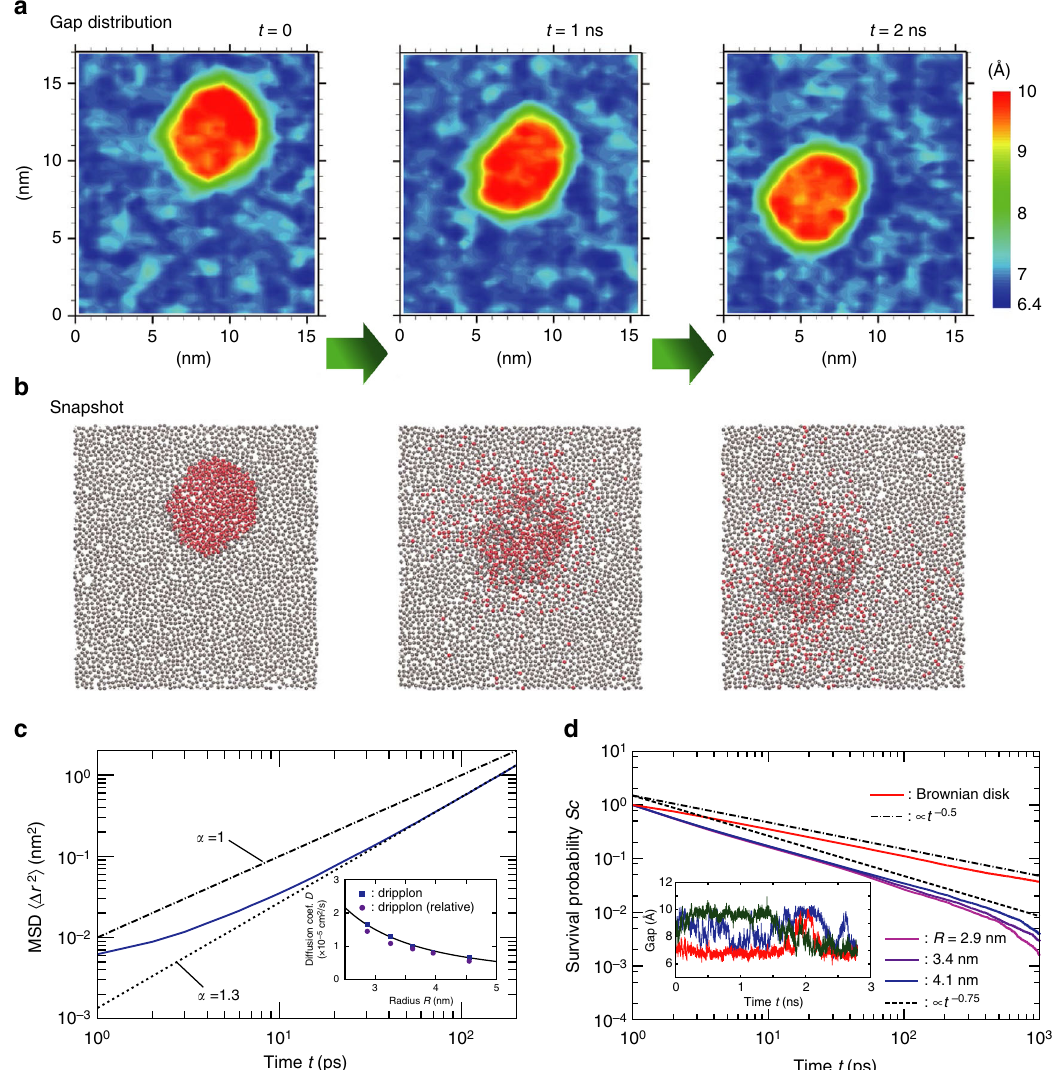
Fig. 5 Dripplon dynamics. a Displacement of a dripplon over time, compared with diffusion of water molecules initially in the dripplon, which is visualized in b . The water molecules belonging to the dripplon at t = 0 are colored in red in b . The average density is ρ av = 12.3 nm − 2 , in the graphene sheets of S = 15.7 × 17.0 nm 2 . See Supplementary Movie 4 for the corresponding video. c Mean-square displacement (MSD) of a dripplon as a function of time, for a (cid:11) (cid:12) ð t Þ (cid:2) t α with α ≈ 1.3. The inset reports the calculated apparent diffusion dripplon with R = 2.9 nm. The MSD highlights superdiffusive behavior, Δ r 2 coef fi cient of a dripplon (as de fi ned in the main text). The solid line is a one-parameter fi t as cR − 2 . d Survival probability within the dripplon. S c ( t ) indicates the probability that a carbon atom participates in the dripplon for longer than time period t (larger than 1 ps). The gap histories measured for three carbon atoms are shown in the